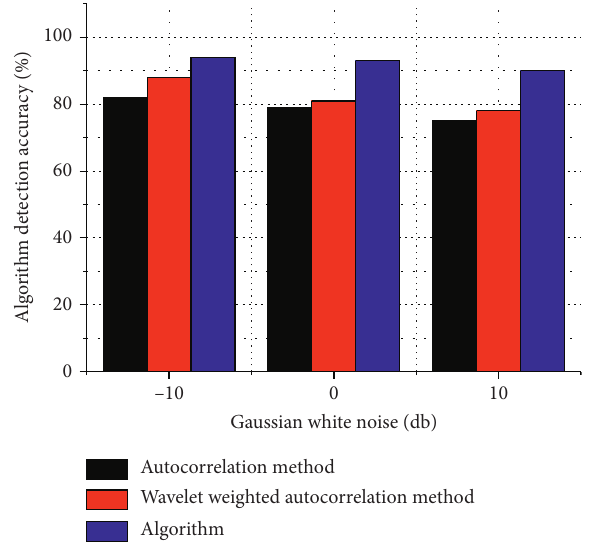
Figure 4: Comparison of the correct rate of base-tone cycle de- tection of the three